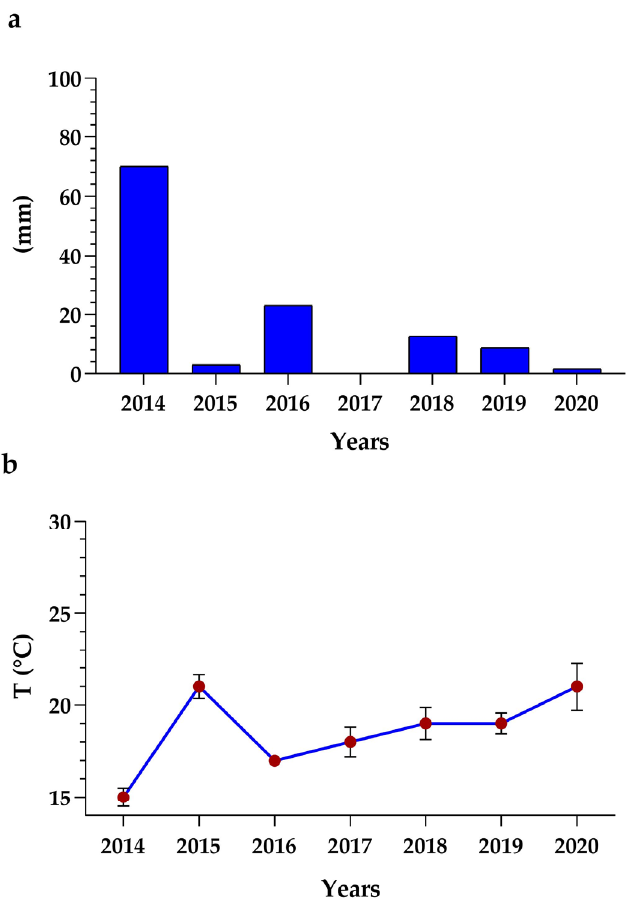
Figure 7. Meteorological data of province of Lecce calculated for each year based on Landsat images acquired from 1 March to 10 May. ( a ) Precipitation; ( b ) Air temperature.